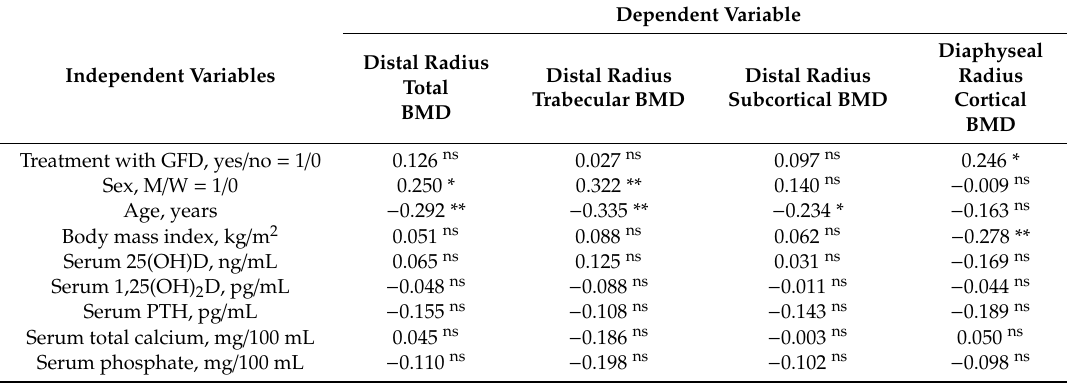
Table 7. Multivariable linear regression of radius BMD (dependent variable) regressed over GFD treatment, sex, age, body mass index, and lab variables: Standardized regression coe ffi cient.